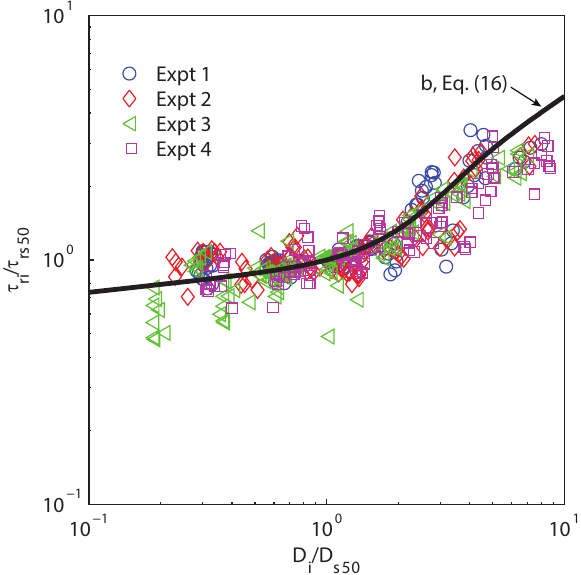
Figure 4. Data points are based on power-law fits to exponent b . The W&CM hiding function (Eq. 16) does a good job matching the data, although it was not fit to these points. The first six measure- ments of each experiment (roughly the first 10min) were excluded because of large scatter associated with the greatest bed instability. The axes reflect the left and right hand sides of Eq. (15), but uses dimensional stresses to be consistent with plots shown in Wilcock and Crowe (2003).